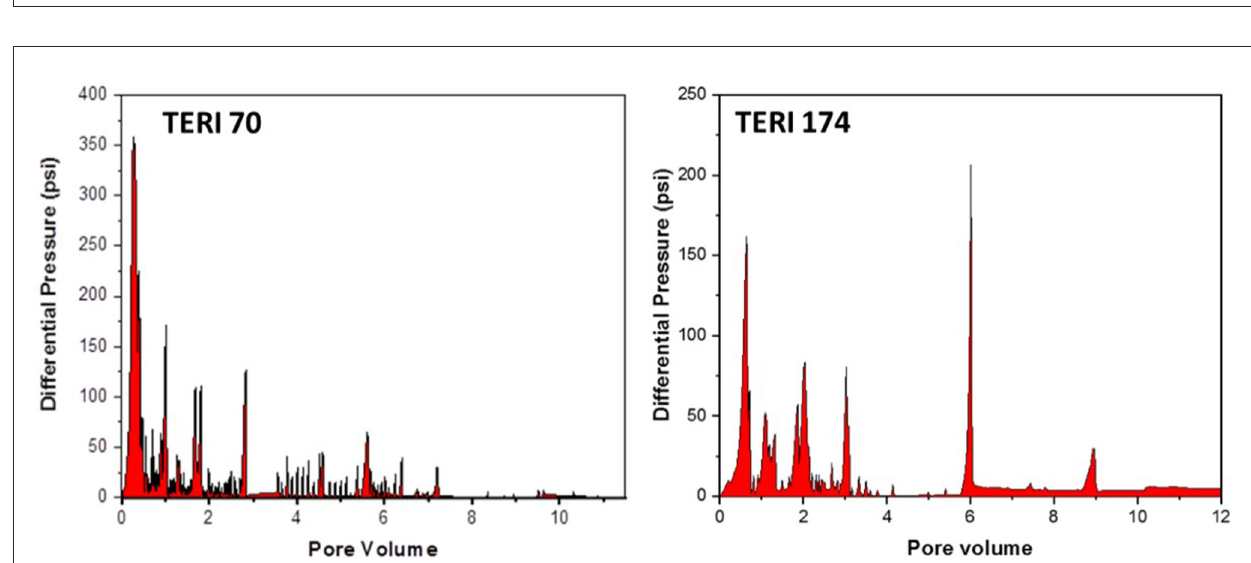
FIGURE11 Variation of differential pressure drop with pore volume injection during microbial flooding in TERIW70 and TERIW174.